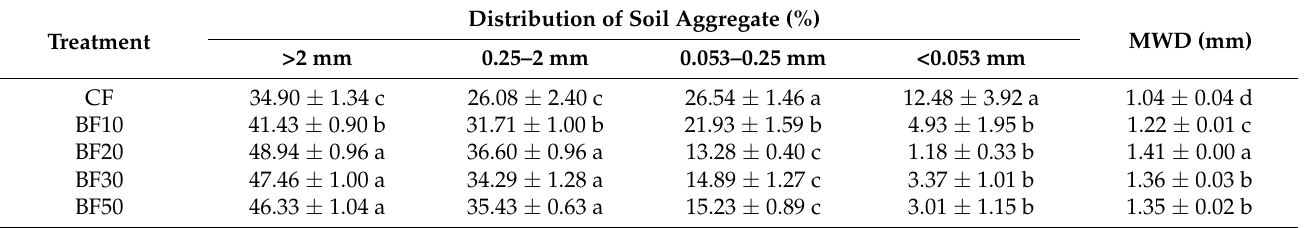
Table 1. Distribution of soil aggregate and soil aggregate stability assessed by dry sieving method. Distribution of Soil Aggregate Treatment